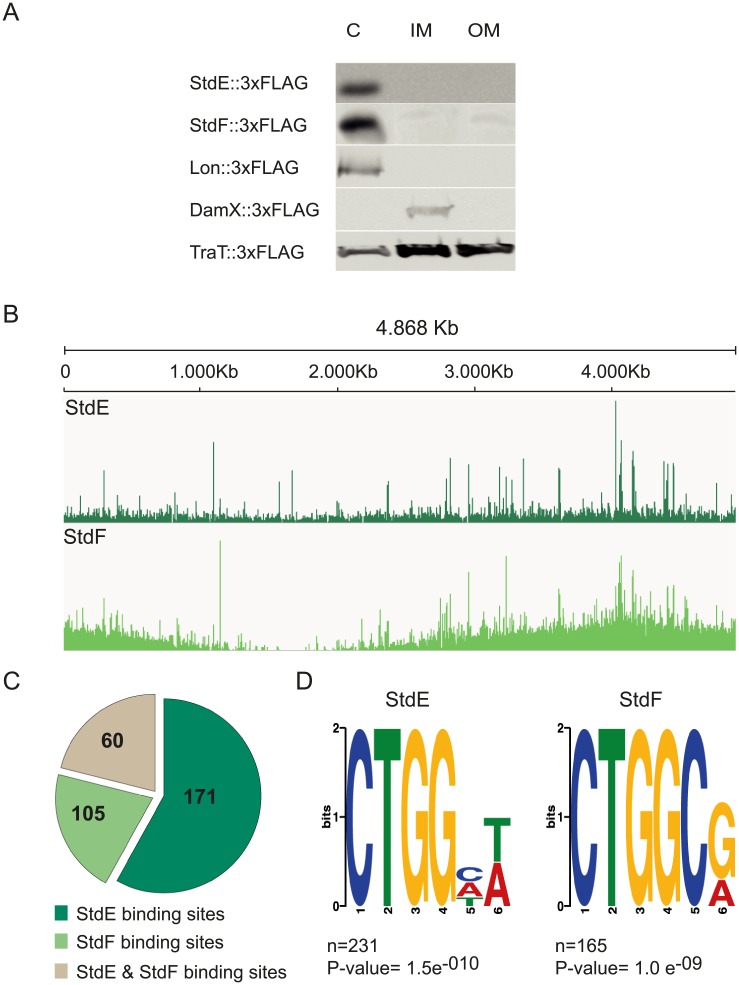
Genome-wide identification of StdE and StdF binding sites by ChIP-seq.A. Subcellular localization of StdE and StdF proteins in cellular fractions (cytoplasm (c), inner membrane (IM) and outer membrane (OM)) using 3xFLAG-tagged versions of the proteins (SV9324 and SV9325, respectively). Controls used for each fraction are Lon, DamX and TraT. B. Visualization of StdE and StdF ChIP-seq data using the Integrative Genomics Viewer (IGV) for S. Typhimurium SL 1344. StdE represents the difference between the StdE IP sample and the mock IP control and the same is valid for StdF. C. The pie chart shows the number of StdE, StdF and StdE & StdF binding sites along the Salmonella enterica genome. D. StdE and StdF binding motifs identified by Meme.